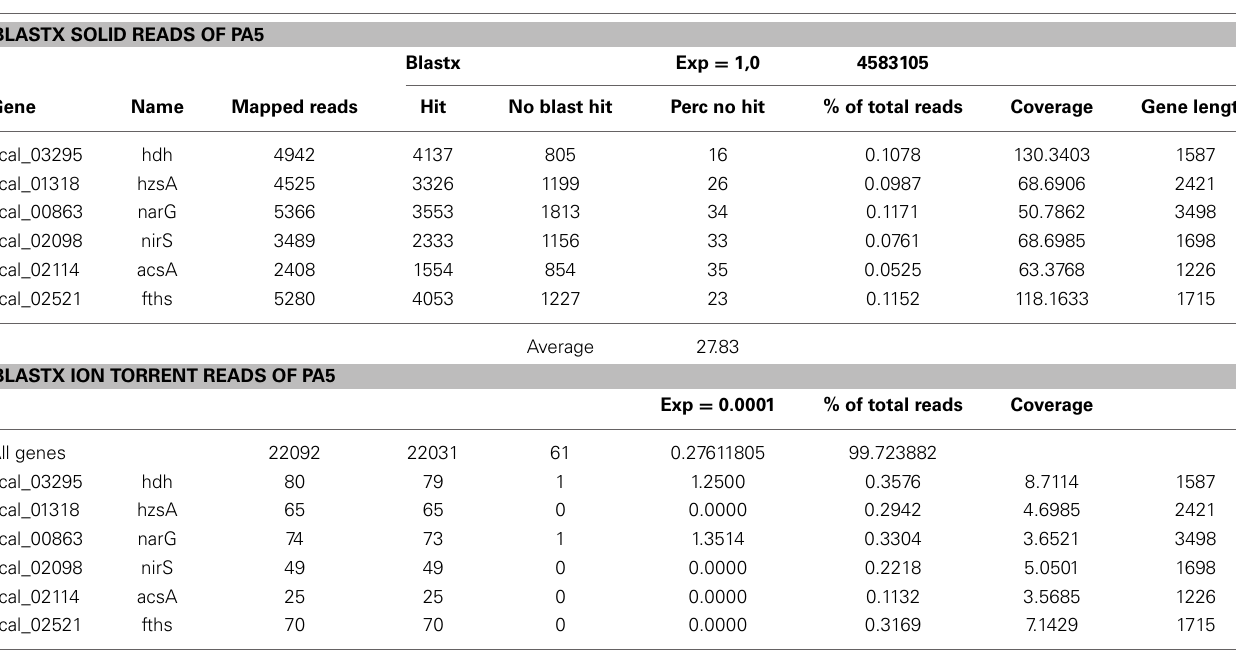
Table A1 | Comparison between mapping and blastx analysis of selected Scalindua genes at station